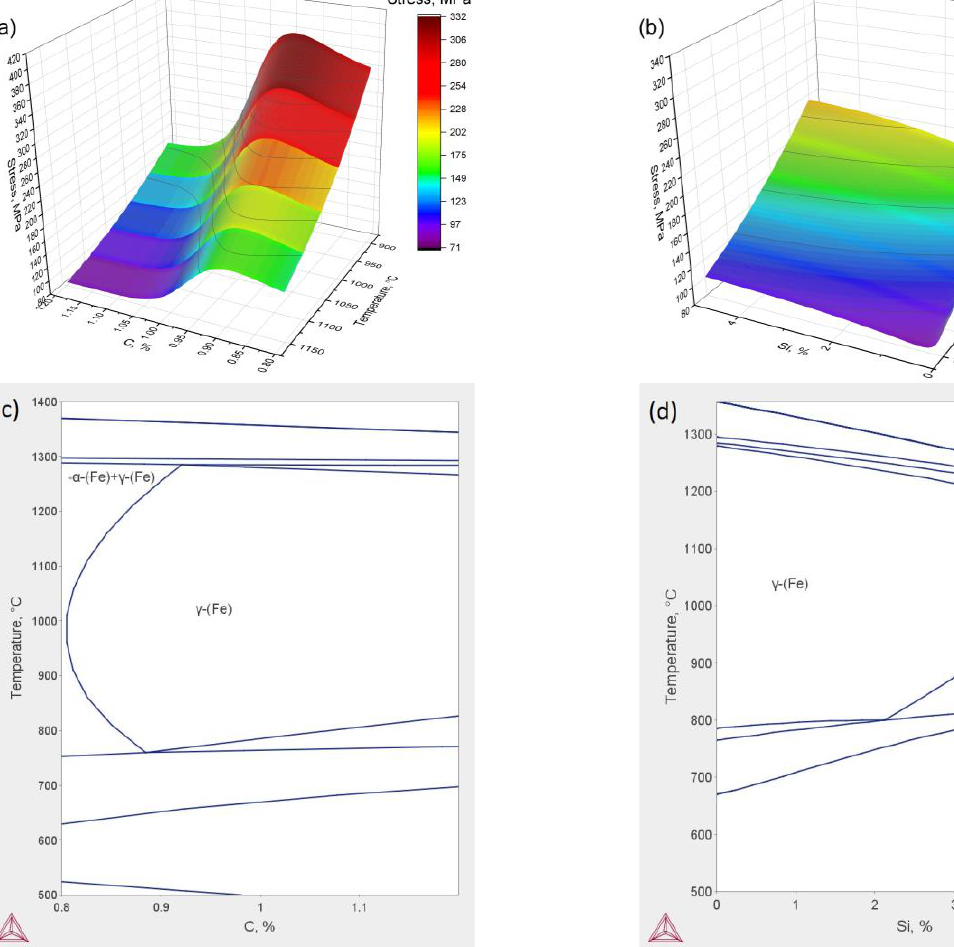
Figure 8. Calculated dependence of the true stress on the temperature and C ( a ) and Si ( b ) content at a strain rate of 1 s − 1 and a true strain of 0.7. The phase diagrams of the Fe–28Mn–8Al–xC ( c ) and Fe–28Mn–8Al–1C–xSi ( d